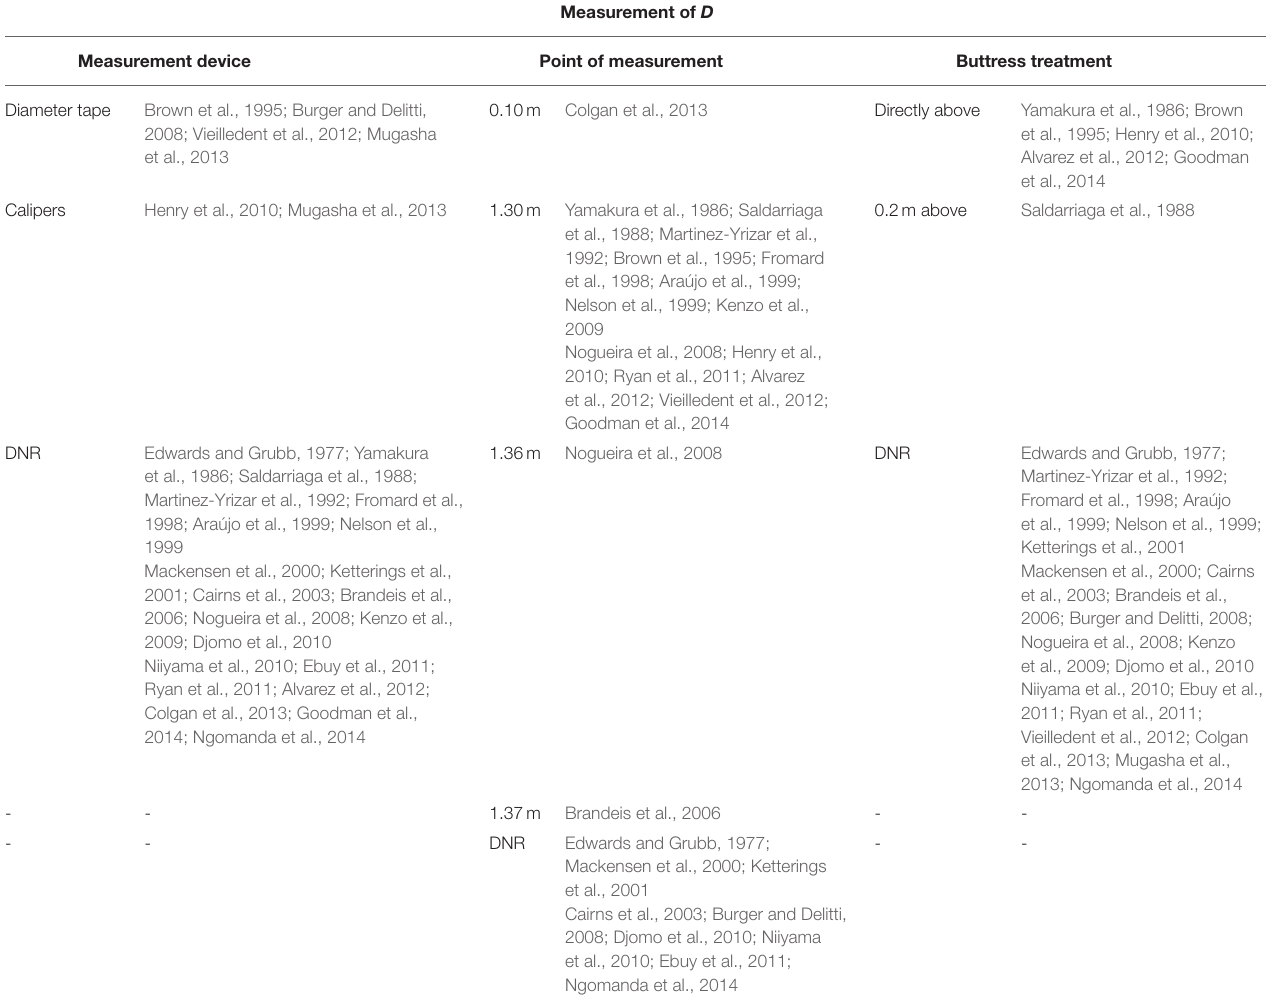
TABLE 1 | The protocol employed across the 26destructive harvest experiments for measuring the predictor variable D